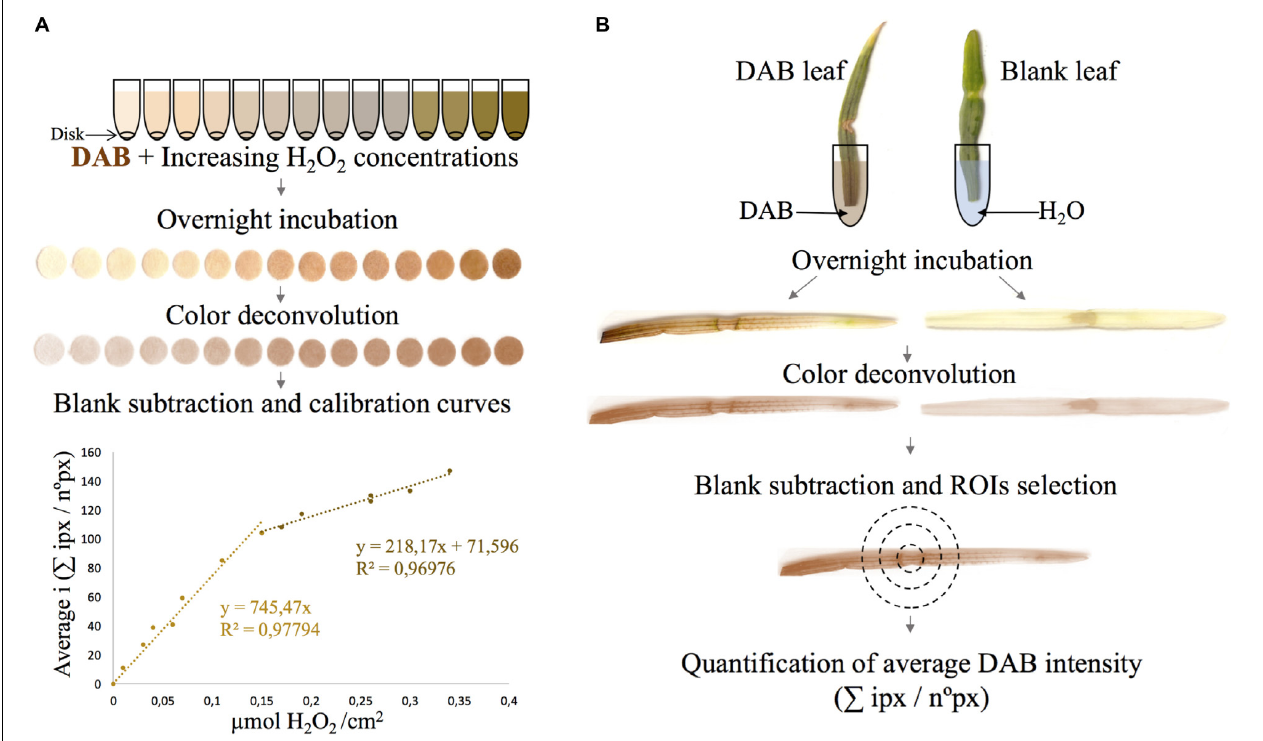
FIGURE 2 | (A) Steps for the generation of H 2 O 2 -DAB intensity calibration curve. Disks are put in microtubes, drenched at different H 2 O 2 concentrations and 1 mg/mL DAB solution is added. After incubation, disks are digitalized and average DAB intensity in the deconvoluted image is determined. Finally, average DAB intensity values are related with those of the several H 2 O 2 concentrations ( µ mol H 2 O 2 /cm 2 ). (B) Leaf incubation in 1 mg/ml DAB solution and processing of the initial leaf RGB image resulting in the deconvoluted 8-bit DAB image. Leaf background average intensity (blank) was subtracted and ROIs were selected in leaf for quantification of the final DAB average pixel intensity of specific